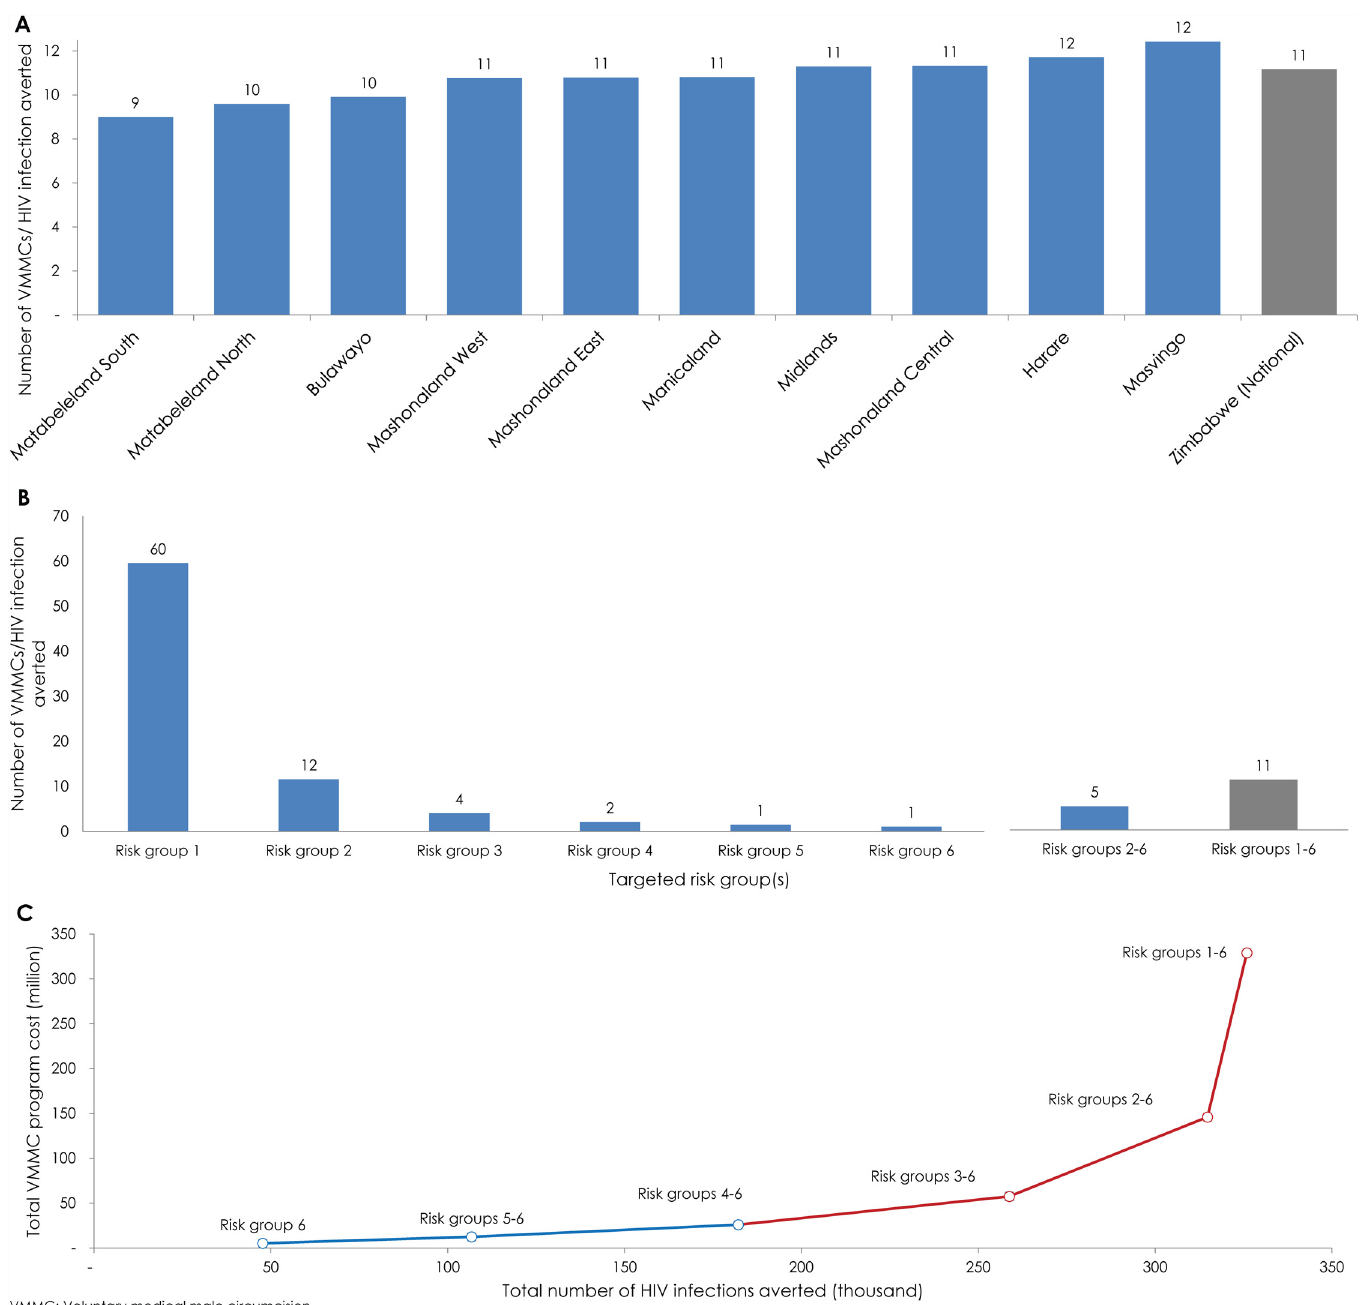
Fig 3. Projected outcomes of geographic and sexual risk-group prioritization. A) Number of voluntary medical male circumcisions (VMMCs) needed to avert one HIV infection ( effectiveness ) by 2025 through geographic prioritization. B) Number of VMMCs needed to avert one HIV infection by 2025 through risk-group prioritization. C) Expansion path curve showing the incremental change in total cost of the VMMC program relative to the incremental change in total number of HIV infections averted for each sexual risk-group targeted scenario. The blue line shows the expansion of the program with minimal diminishing of returns, and the red line shows the expansion of the program with considerable diminishing of returns.